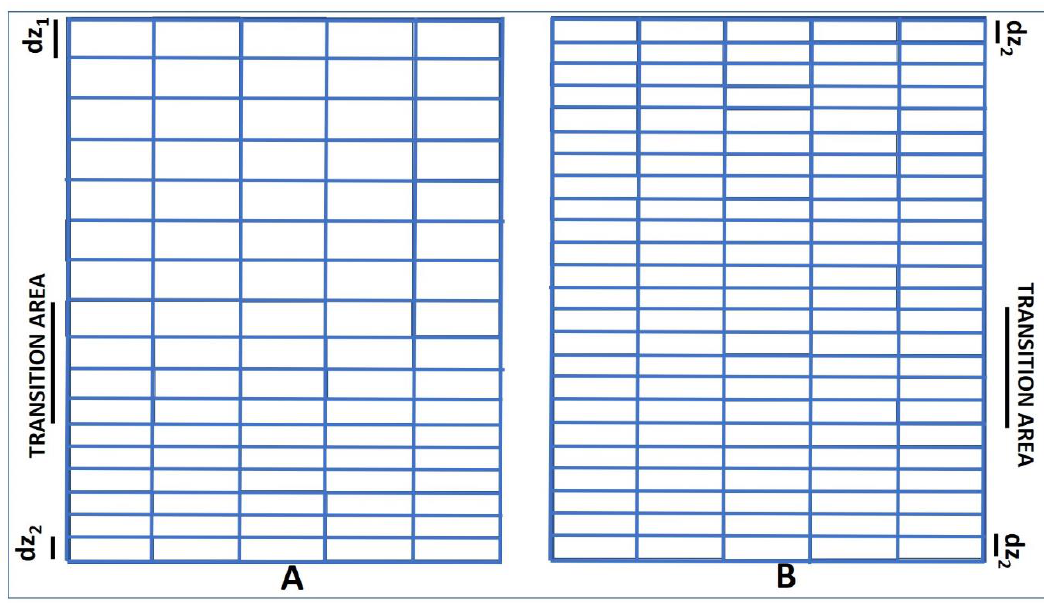
Figure 2. Pictorial synopsis for vertical velocity transition: Image ( A ) represents the initial situation after separate time-depth conversion. Image ( B ) represents the situation after resampling of the part with faster propagation velocity and the transition area.